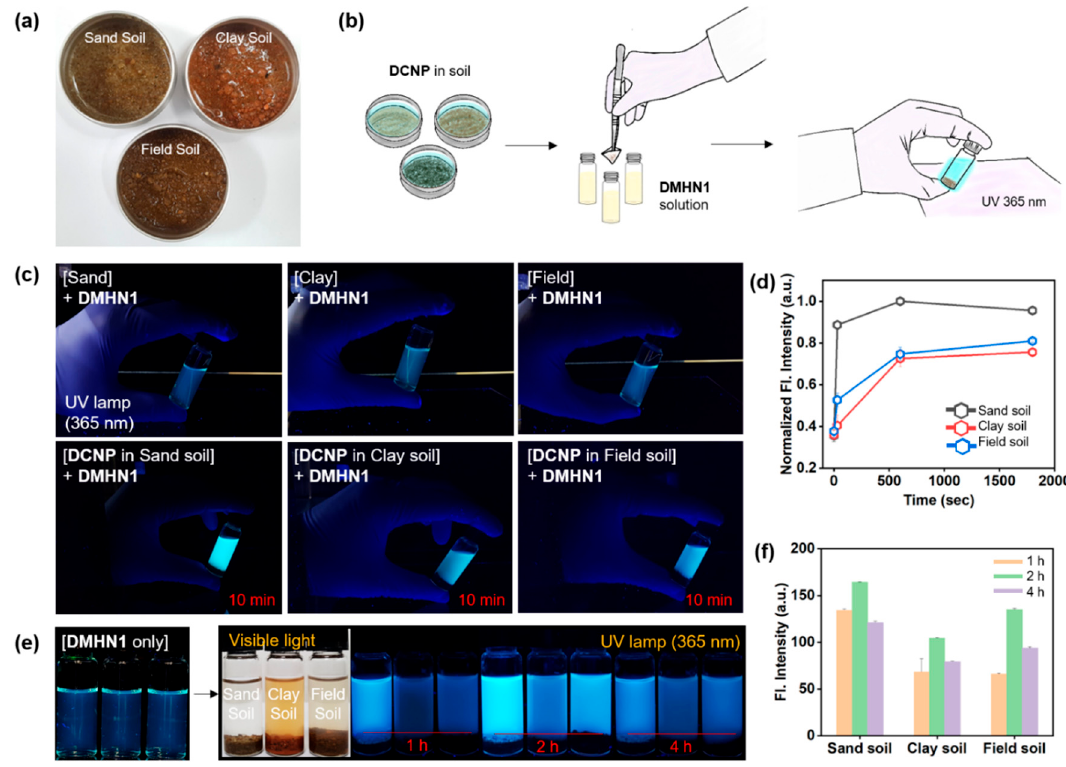
Figure 4. ( a ) Photos of DCNP moistened soils under natural light. ( b ) Schematic illustration of the soil test. DCNP moistened soils transferred to a vial of CH 3 CN (1% Et 3 N) (3 mL) containing DMHN1 (10 µ M). ( c ) Photos of DMHN1 (top, 10 µ M) in CH 3 CN (1% Et 3 N) and after adding DCNP moistened soils (bottom, 1 g, DCNP content: 100 mM). These photos were taken after 10 min at 25 ◦ C. ( d ) The fluorescence emission changes of solutions are shown in panel ( c ) after the soil settled. The relative intensity was calculated by Image-J software. ( e ) Photos of DMHN1 (10 µ M) after adding each soil (1 g) moistened with DCNP (100 mM) in CH 3 CN (1% Et 3 N) under UV light (365 nm). ( f ) Fluorescence intensity plot of solutions as shown in panel ( e ) after the soil settles. The relative intensity was obtained by Image-J software.